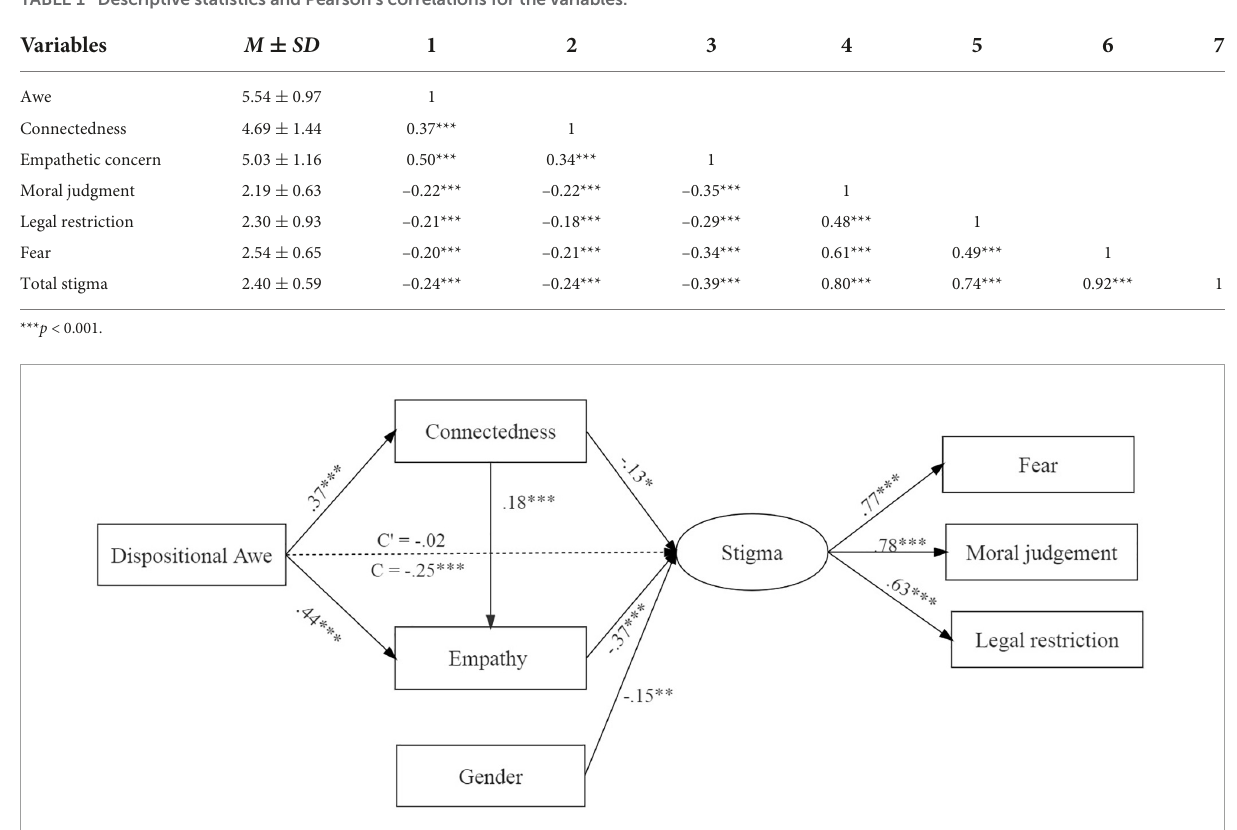
FIGURE1 Mediation model for the effect of awe on AIDS-related stigma in Study 1. All path coefficients were standardized. The dotted line indicates the insignificant path coefficient. The model fitting was satisfactory, χ 2 (10) = 11.72, p = 0.304, CFI = 1, NFI = 0.98, GFI = 0.99, RMSEM =